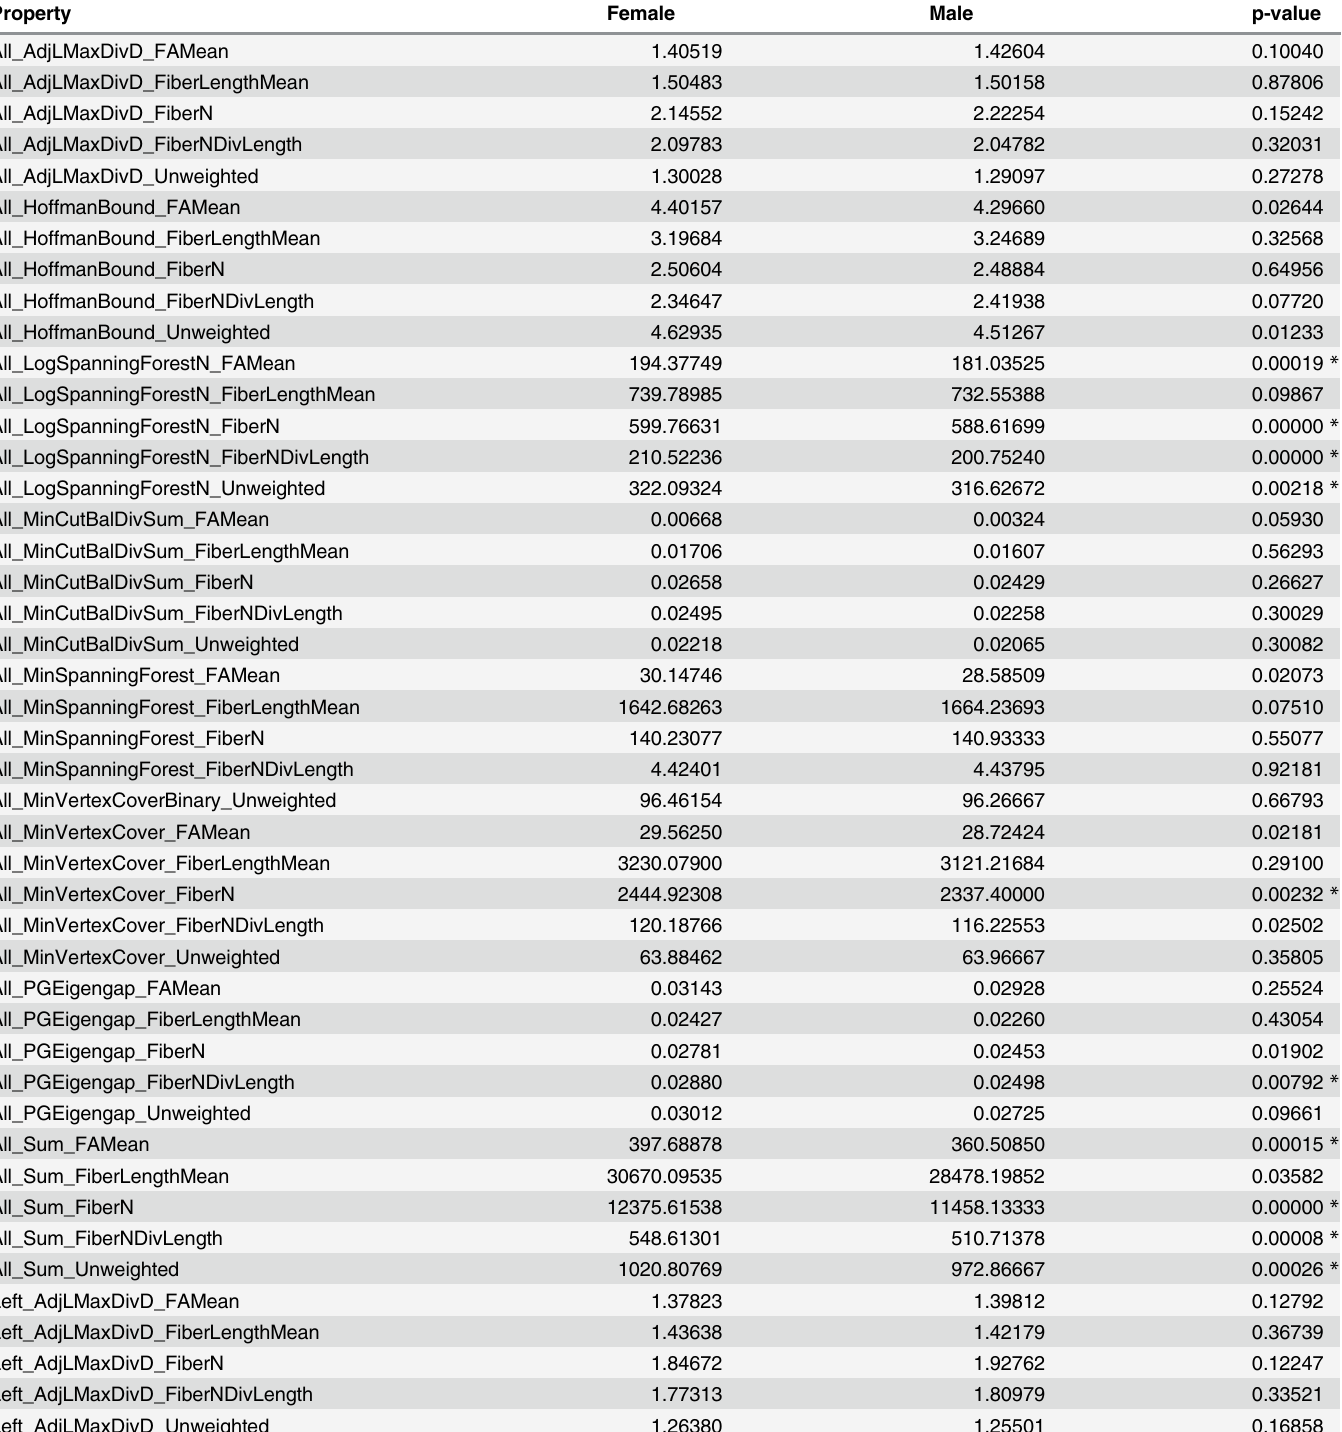
Table 3. The graph-theoretic parameters computed for the 129-vertex graphs. The table contains their arithmetic means in the male and female groups, and the corresponding p-values in round 1 (see the “ Statistical analysis ” subsection). The results of the graph-parameters are defined in the caption of Table 1. Significant differences ( p < 0.01) are denoted with an asterisk in the last column.